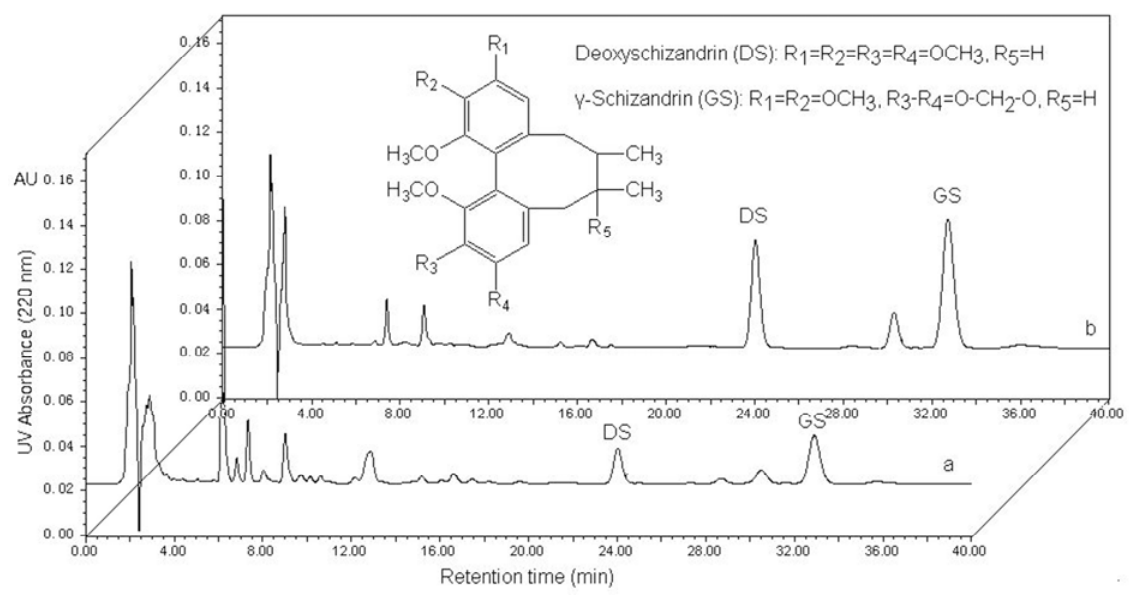
Figure 1. HPLC chromatograms of sample solution of S. chinensis extracts ( a ) and desorption solution ( b ) from HPD5000. Inset: The molecular structures of deoxyschizandrin [DS] and γ -schizandrin